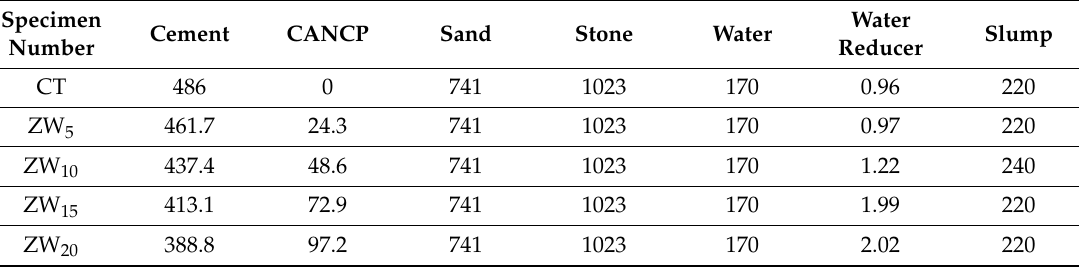
Table 5. Mix proportion and slump (kg / m 3